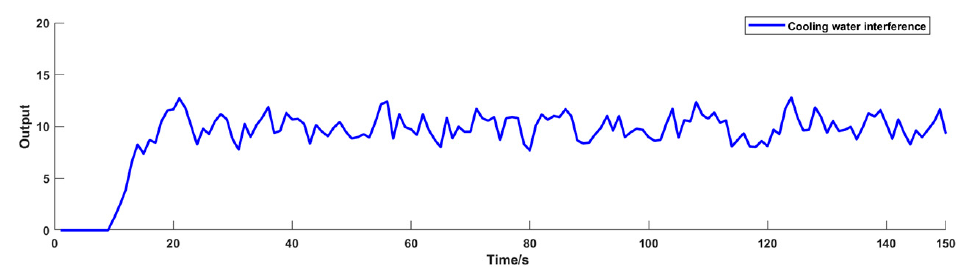
Figure 7. Cooling water flow disturbance.